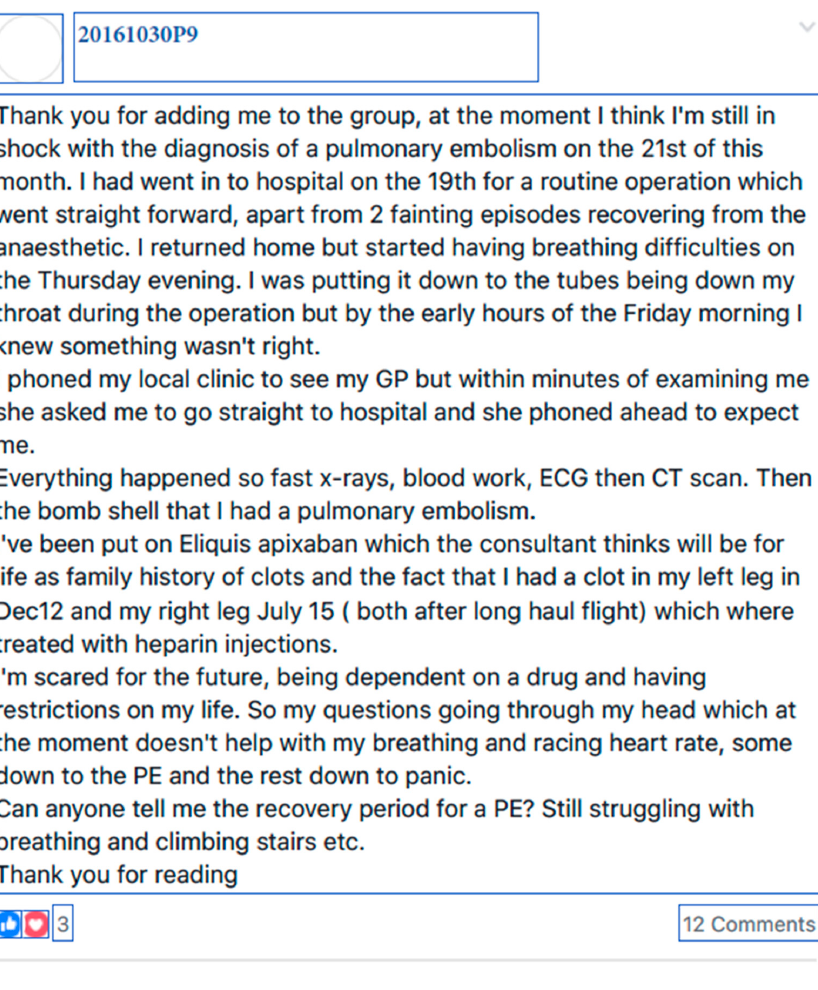
Figure A1. 20161030P9’S Original Post to PEA Facebook Group.